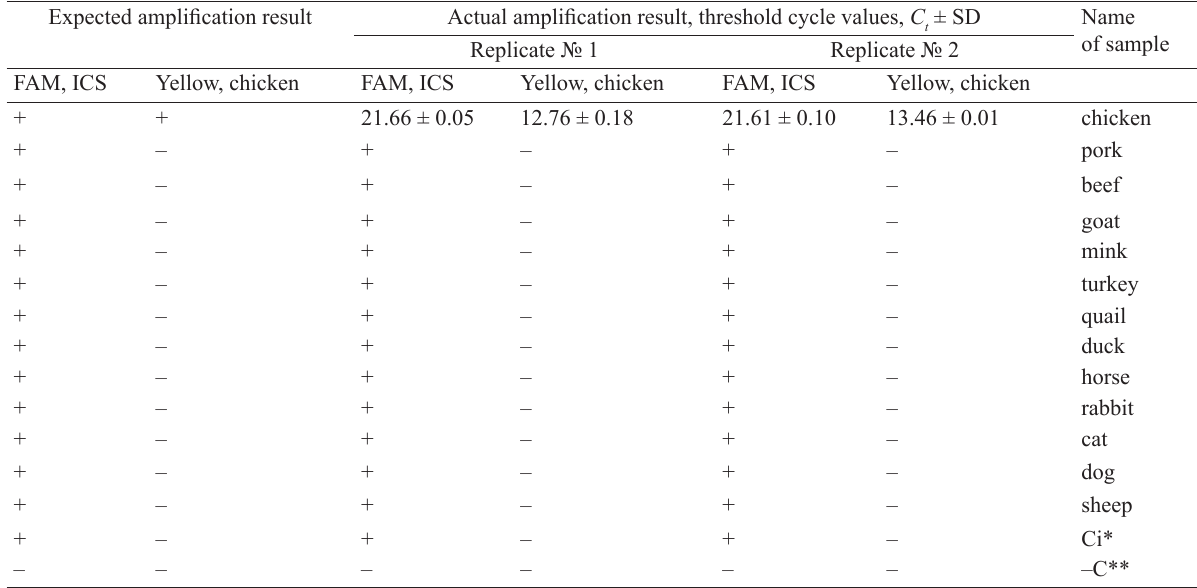
Table 2 Specificity assessment of the duplex PCR system for chicken identification Expected amplification result